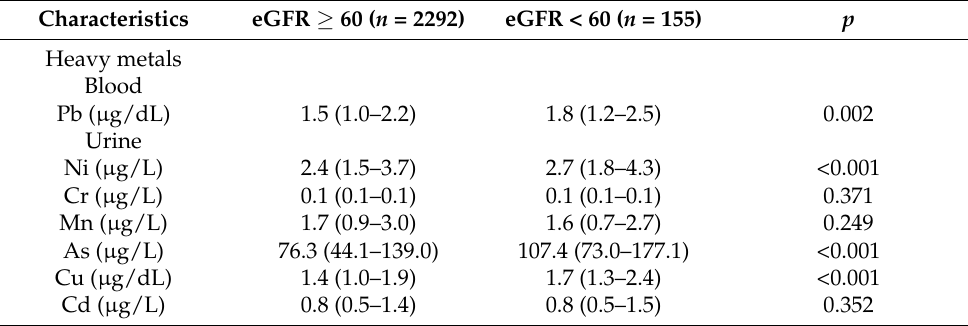
Table 3. Comparison of clinical characteristics among participants with and without an eGFR of <60 mL/min/1.73 m 2.